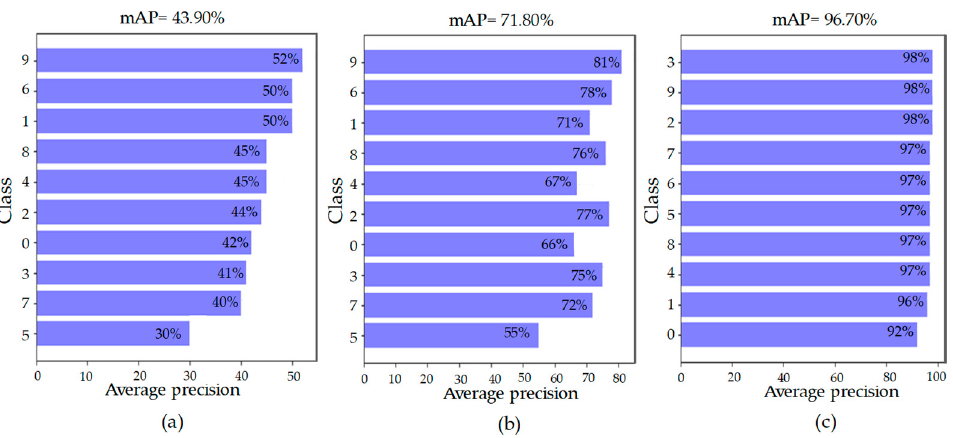
Figure 15. mAP comparison results. ( a ), ( b ), ( c ) represent the mAP results on bicubic results (3×), proposed SR results (3×), and HR images, respectively.